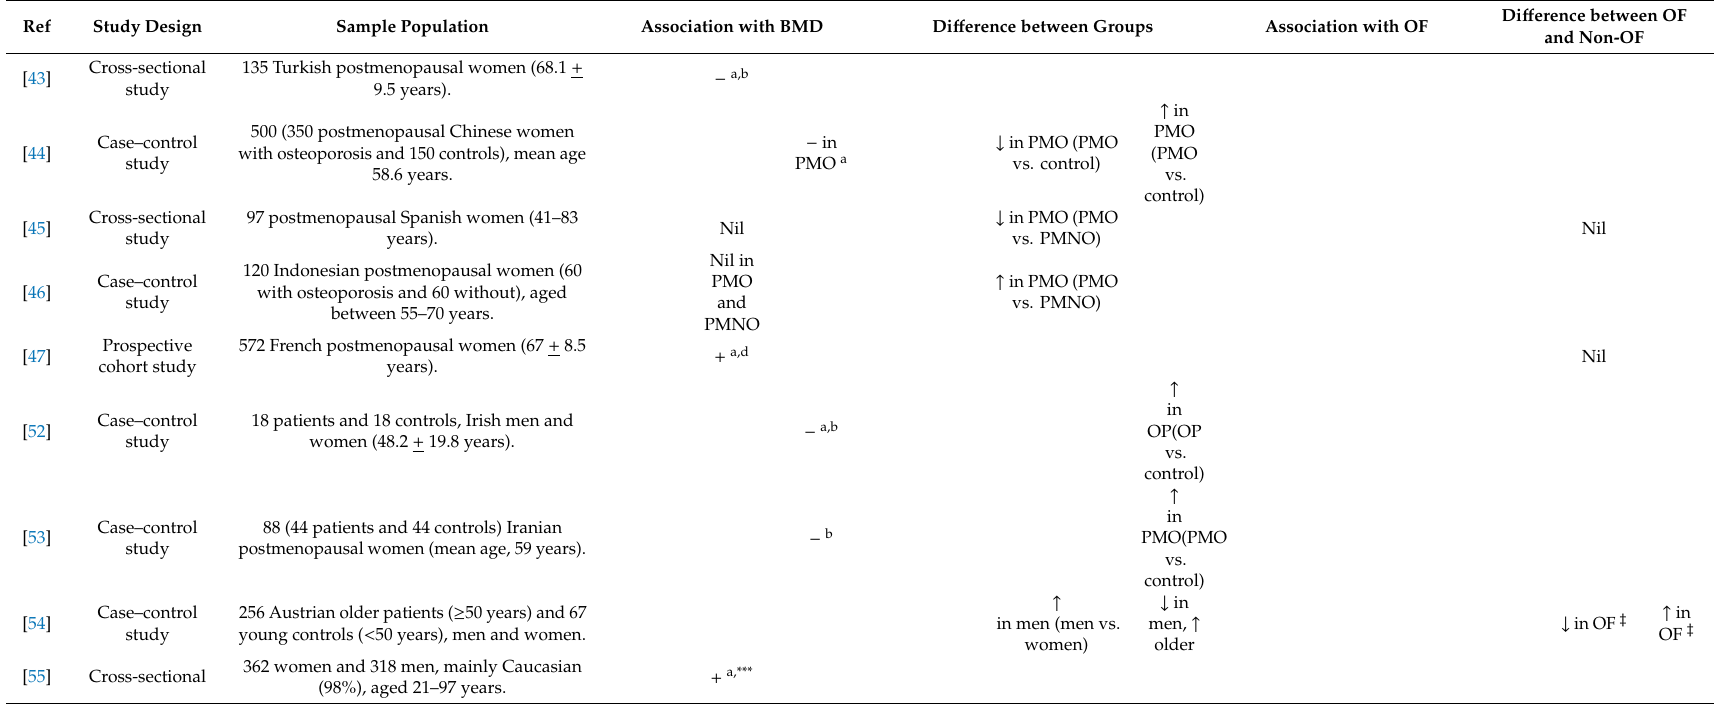
BMD: bone mineral density; DKK1: dickkopf-1; FGF23: fibroblast growth factor-23; OF: osteoporotic fracture; PMO: postmenopausal women with osteoporosis; PMNO: postmenopausal women without osteoporosis; SOST: sclerostin; a: lumbar spine, b: femoral neck, c: trochanter, d: total hip, e: whole body, nil: no significant association. * compared to normal